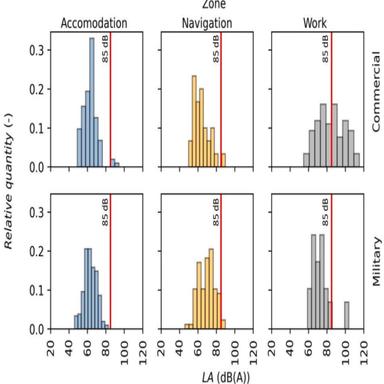
Distribution of total dB(A) levels classified by zone and ship typology.